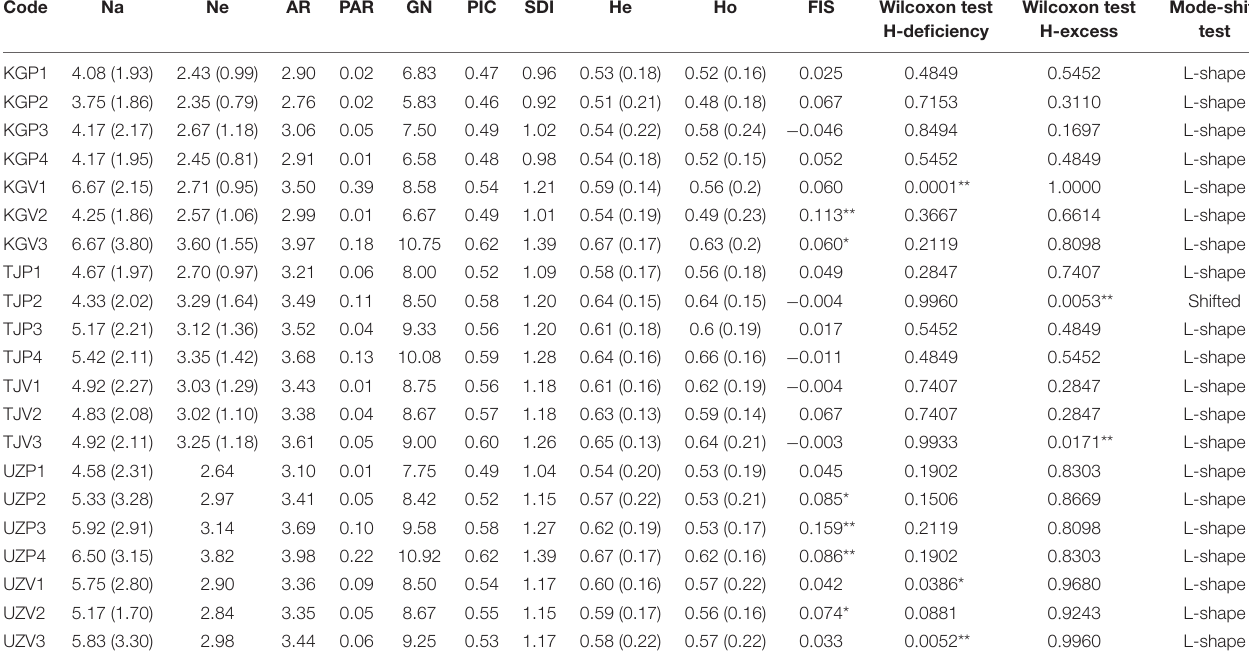
TABLE 4 | Within population genetic diversity of the 21 walnut populations